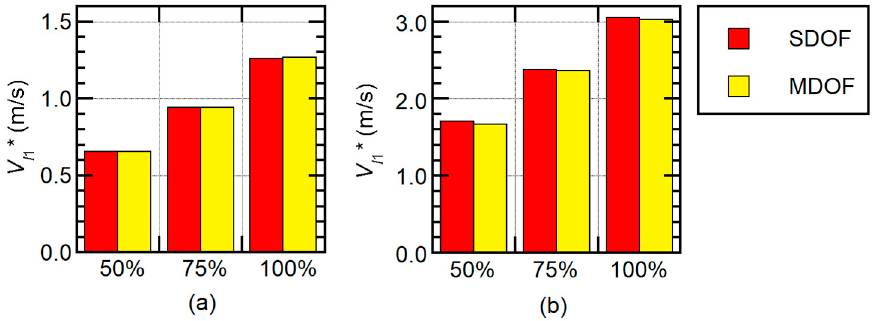
Figure 22. Comparisons of equivalent velocities of cumulative energy input for first mode: ( a ) Art-S series; ( b ) Art-L series.